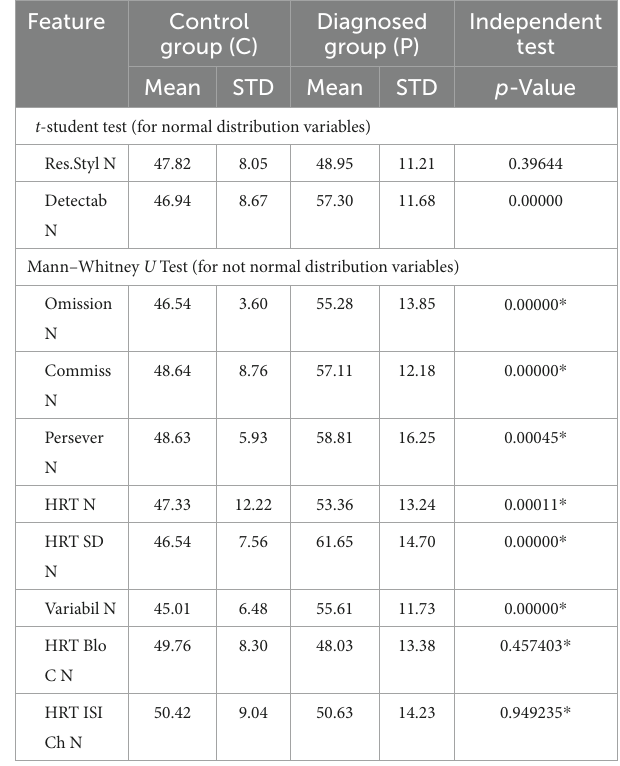
TABLE 2 Results from numerical features from CPT3 ™ by groups.